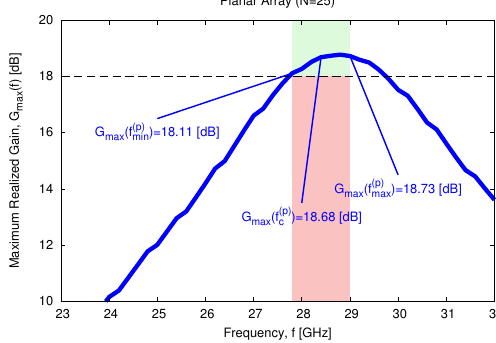
(cid:104) (cid:105) ( p ) ( p ) = [ 27.8, 29.0 ] (GHz))—Plot of the maximum f , f max min